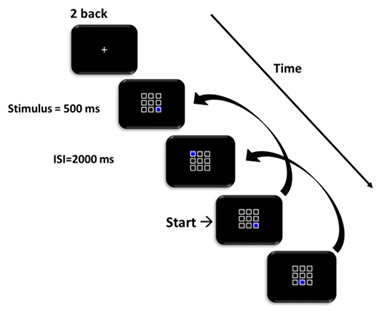
Schematic of the 2-back task. Participants responded whether the position of the blue square matched the position on two trials prior.